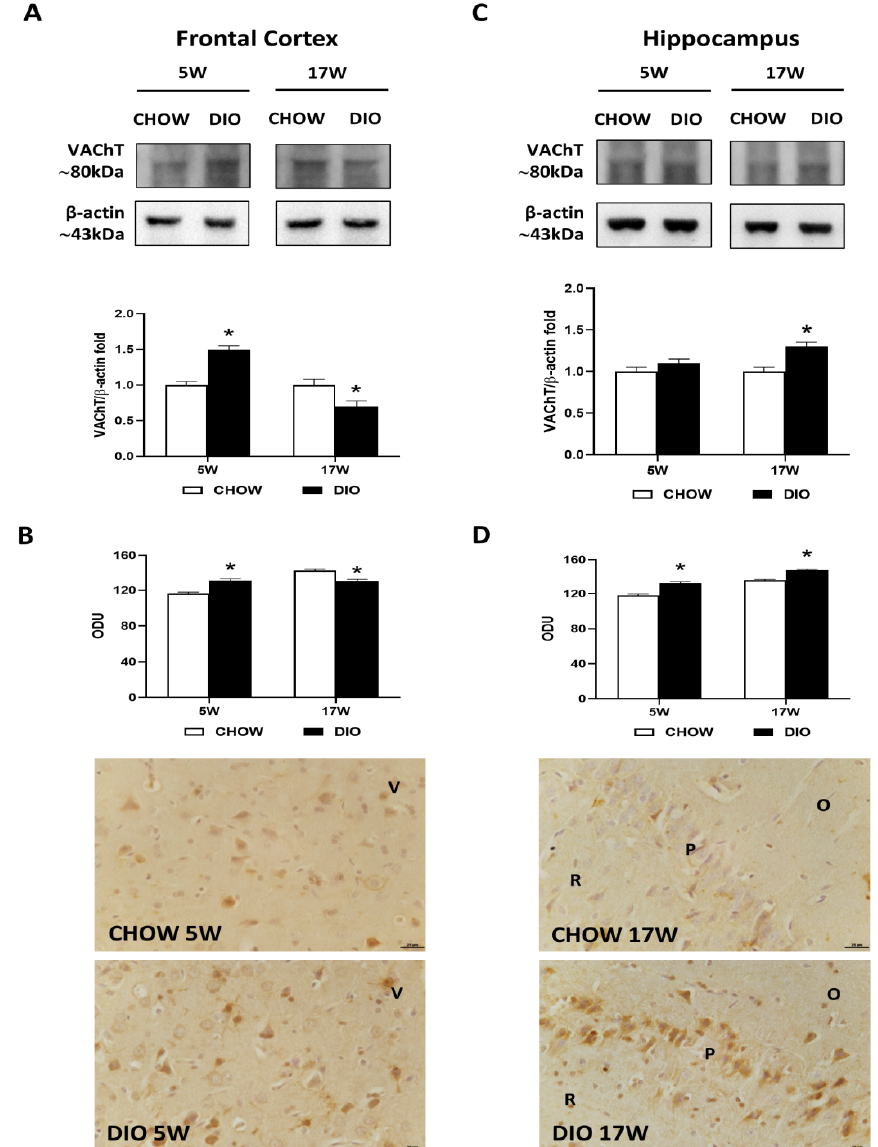
Figure 3. Western blot and immunohistochemistry of vesicular acetylcholine transporter (VAChT). Samples of the frontal cortex ( A ) and hippocampus ( C ) from rats fed with a standard diet (CHOW rats) and high-fat diet (DIO rats) for 5 and 17 weeks were immunoblotted with anti-VAChT. Graphs report the densitometric data with CHOW rats as control. ChAT membranes were stripped and incubated with anti-VAChT antibodies. β -actin control images were reused for illustrative purposes. VAChT immunoreaction intensity in the frontal cortex ( B ) and the hippocampus ( D ) from CHOW and DIO rats after 5 and 17 weeks of a diet was measured in optical density unit (ODU). Data are mean ± S.E.M. * p < 0.05 vs. age-matched CHOW rats. CHOW rats 5 weeks n = 8; DIO rats 5 weeks n = 8; CHOW rats 17 weeks n = 8; DIO rats 17 weeks n = 9. Representative pictures of CHOW and DIO rats frontal cortex after 5 weeks ( B ) and hippocampus, CA1 subfield, after 17 weeks ( D ) of diet. V, fifth layer of frontal cortex; O, stratum oriens ; P, pyramidal neurons; R, stratum radiatum . Scale bar: 25 μ m.